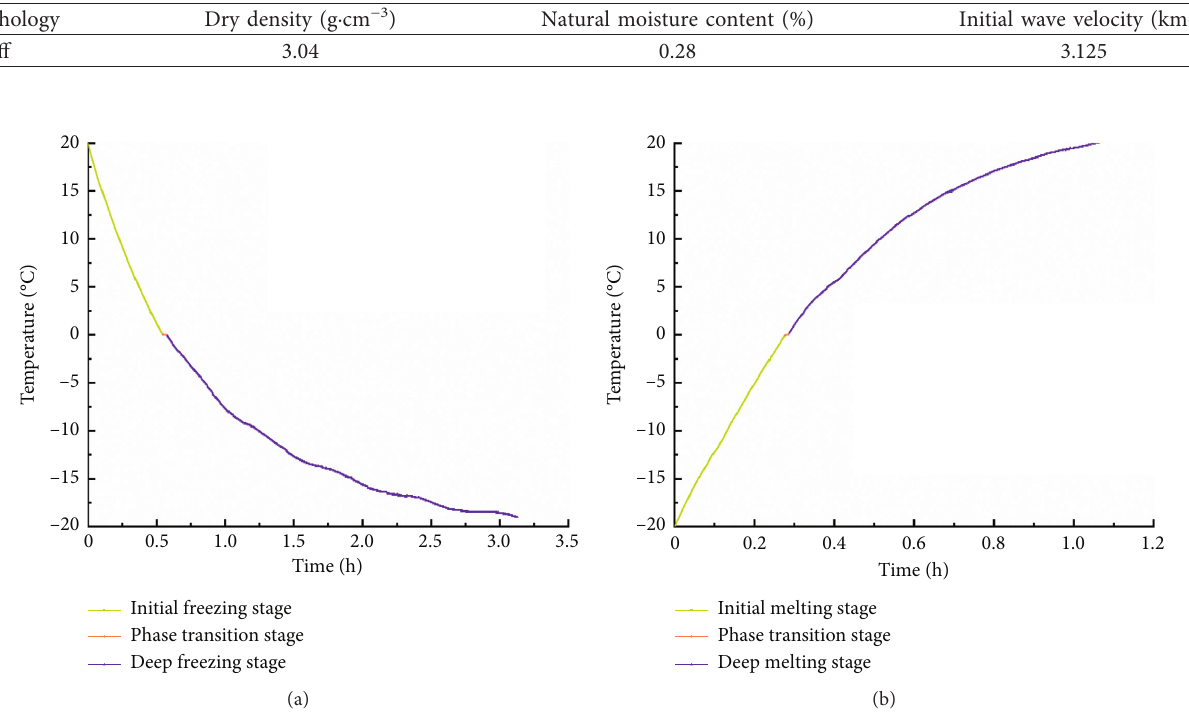
Table 1: Initial physical parameters of tuff.